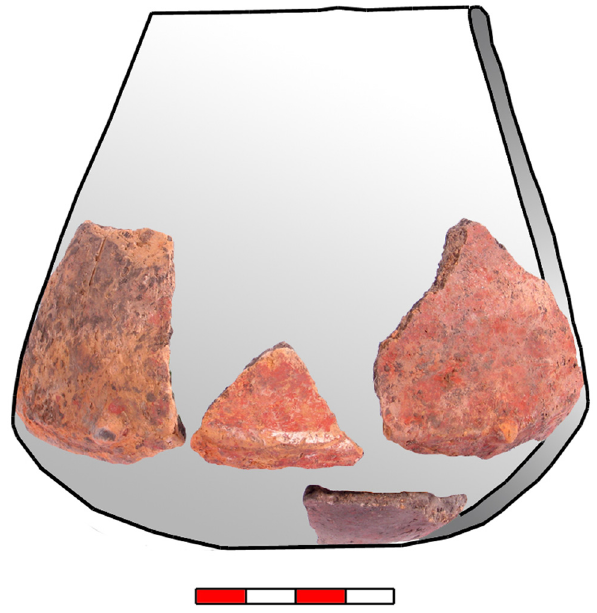
Figure 11: Pear - shaped vessel with red and white oil paintings from Targowisko site 12 – 13 ( acc. to Czerniak et al., 2007 )